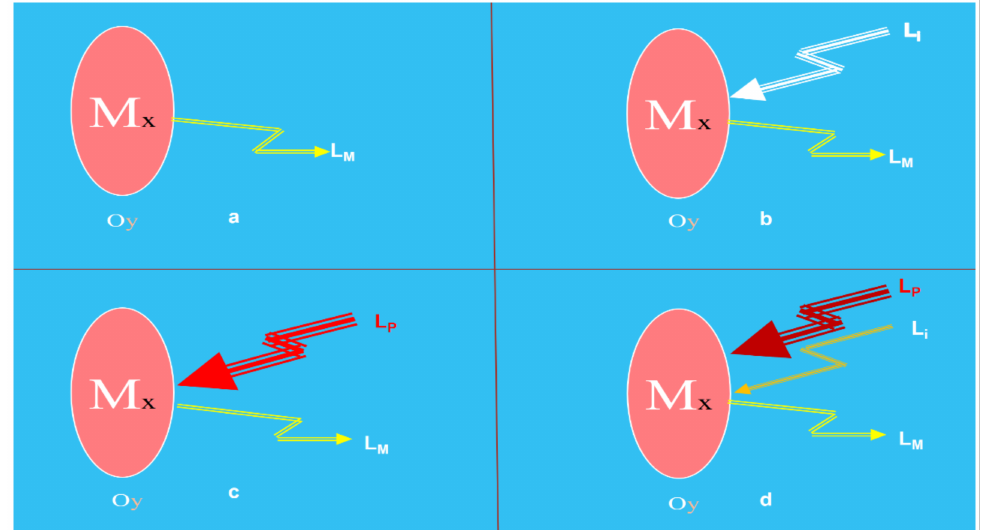
Figure 1. The focus at the measurand on/in the object illustrates main sensing possibilities using light techniques. Light modulated by the measurand (L M ) on/in the object: ( a ) produced by the object itself; ( b ) returning from the object consequence of the interrogation light (Li); ( c ) produced as a consequence of a pumping light (Lp) and ( d ) produced as a consequence of a pumping and interrogation lights. Courtesy of the